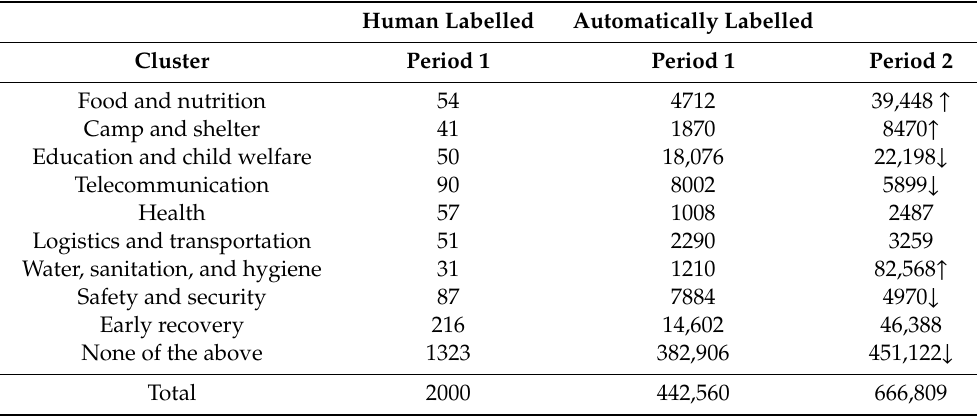
Table 2. Classification of informative tweets posted during Typhoon Yolanda, according to the Humanitarian Clusters Framework. (Up / down arrows indicate relative increase / decrease of 50% or more in period 2, proportional to the total number of tweets in each period)